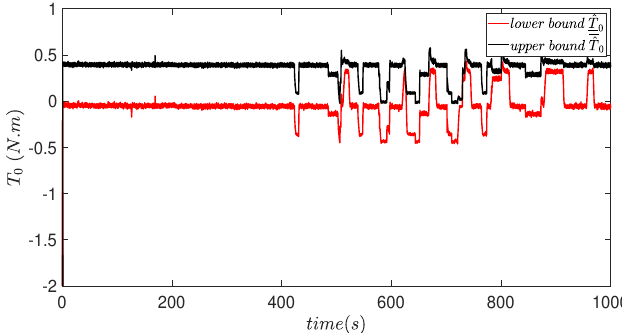
Figure 11. Upper and lower bound estimations of T 0 ( k )